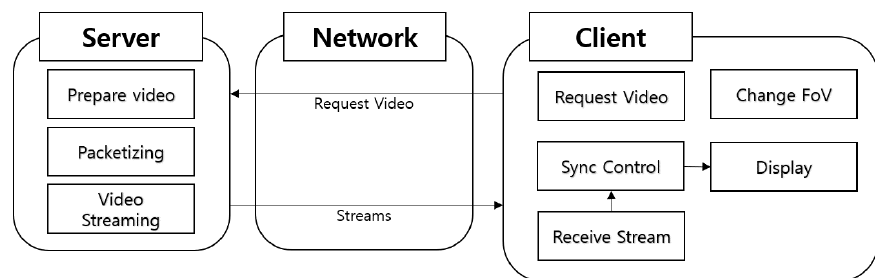
Figure 21. Client system configuration. The server prepares video for output through